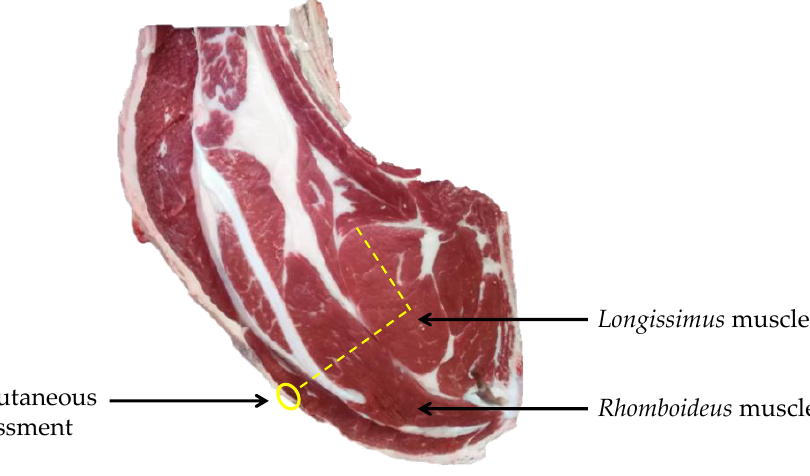
Figure 1. Picture at the 6th rib level and localization of some muscles and measures. After that, a sample of two beef ribs (the 5th and the 4th ribs) was collected and deboned. Each sample was individually vacuum-packaged and aged for 14 days at 4 ◦ C.